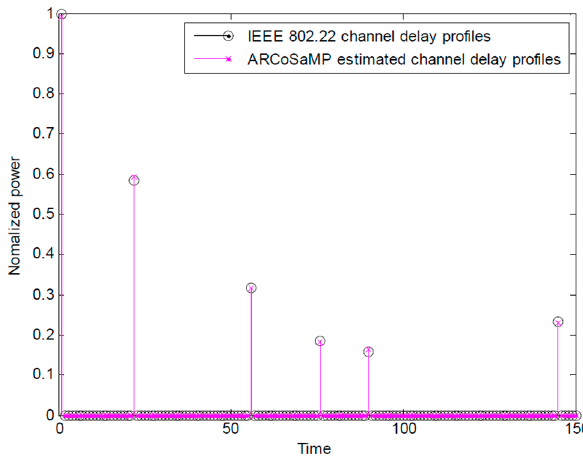
Figure 3. IEEE 802.22 channel delay profile and estimated channel delay profile.